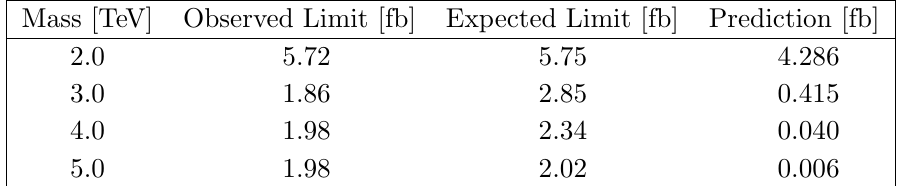
Table 2 . Observed and expected limits at 95% CL on cross-section times branching ratio for WW + ZZ production for di(cid:11)erent radion masses m times branching